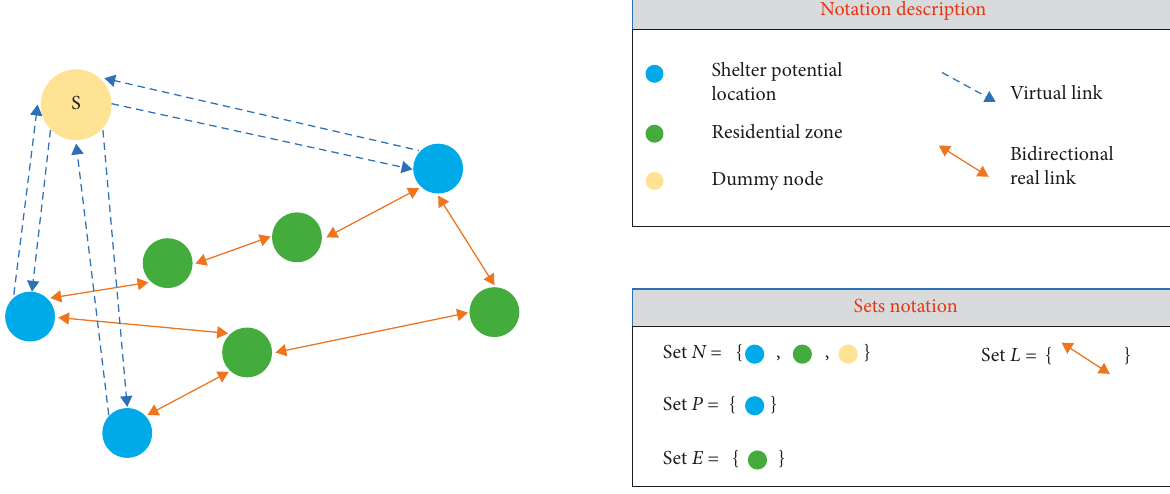
Figure 1: Network representation after incorporation of the dummy node. Table 1: Notation adopted in proposed